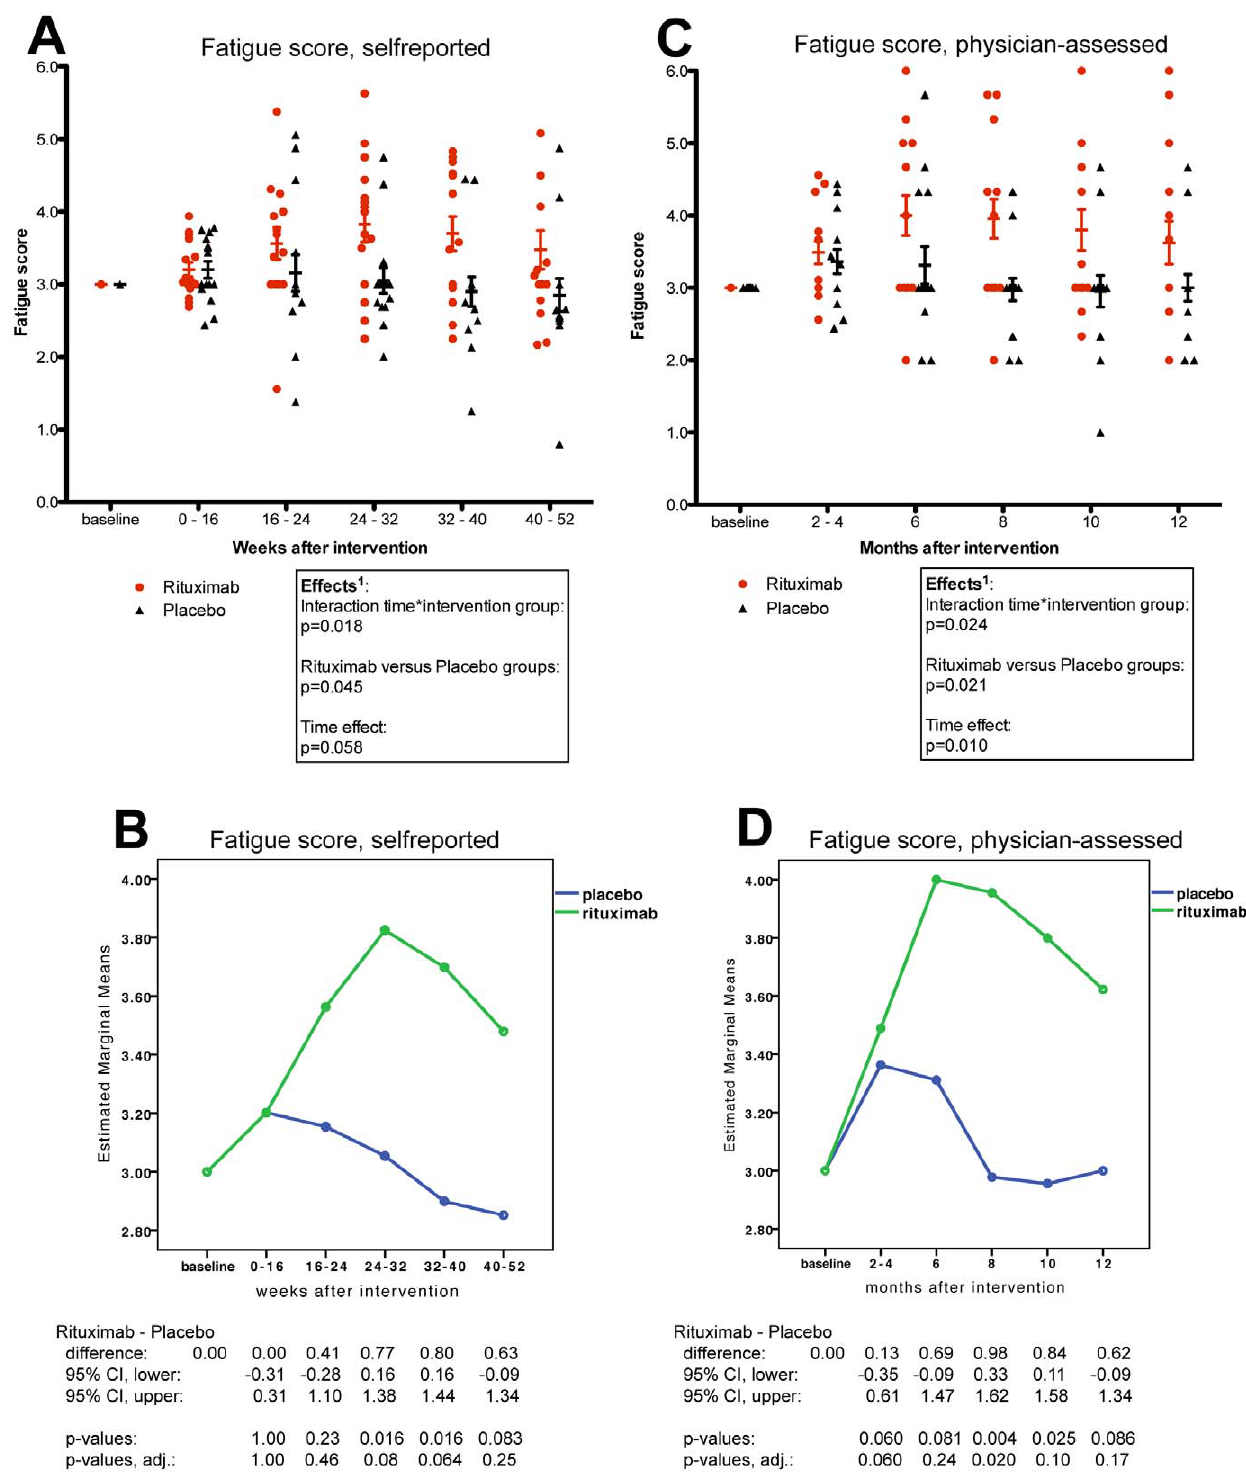
Figure 2. Fatigue scores in Rituximab and Placebo groups, self-reported and physician-assessed. In panel A, the self-reported Fatigue scores were calculated for each patient every second week, from the mean of the four symptoms: Fatigue, Post-exertional exhaustion, Need for rest, Daily functioning. Then the mean values in Fatigue scores for the time intervals during follow-up were plotted. In panel C, the physician-assessed Fatigue scores were calculated from the mean of the same four symptoms, registered by the physician at the visits in the outpatient clinic. In panel B and D, estimated marginal means for self-reported and physician-assessed Fatigue scores during follow-up are shown. The scales on Y-axes were 0–6 (0: Major worsening; 1: Moderate worsening; 2: Slight worsening; 3: No change; 4: Slight improvement; 5: Moderate improvement; 6: Major improvement). The differences in distribution of Fatigue scores during follow-up, between the Rituximab and Placebo groups, were assessed by General Linear Model (GLM) for repeated measures, analysing the effects of time, the interaction time by intervention group, and the overall